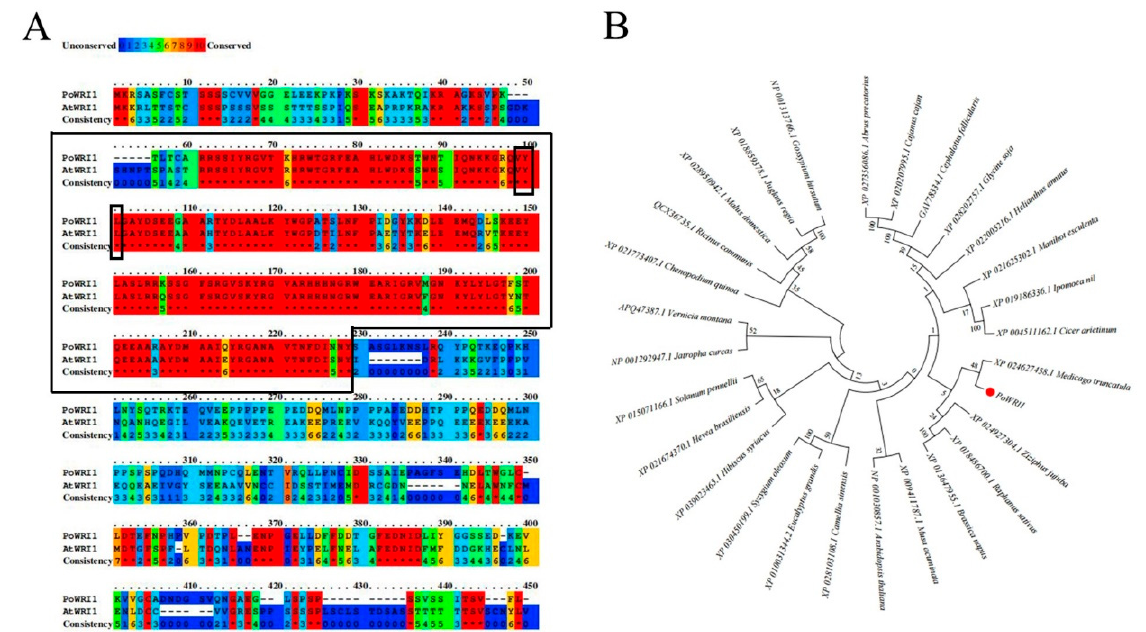
Figure 2. Sequence analysis of PoWRI1 . ( A ) Alignment of protein sequence of PoWRI1 (MW930196) and AtWRI1 (NP_001030857.1). Most of the similarity between protein sequences of PoWRI1 and AtWRI1 occurs at the AP2 regions of the protein (highlighted by boxes). Conservation of amino acids is denoted by different colors as illustrated by the scale bar. ( B ) Phylogeny tree of WRI1 homologs including Paeonia ostii (MW930196), Vernicia montana (APQ47387.1), Cephalotus follicularis (GAV78334.1), Arabidopsis thaliana (NP_001030857.1), Jatropha curcas (NP_001292947.1), Gossypium hirsutum (NP_001313766.1), Ricinus communis (QCX36735.1), Cicer arietinum (XP_004511162.1), Musa acuminata (XP_009411787.1), Eucalyptus grandis (XP_010031344.2), Brassica napus (XP_013647955.1), Solanum pennellii (XP_015071166.1), Raphanus sativus